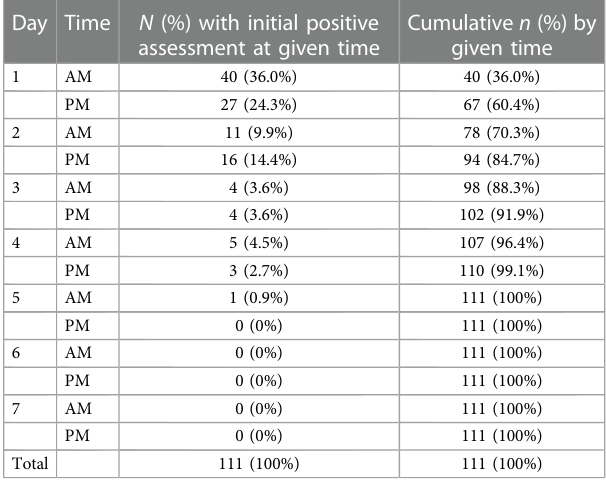
TABLE 2 First delirium event for patients ( n =111) with any positive delirium during the fi rst 7 postoperative days.